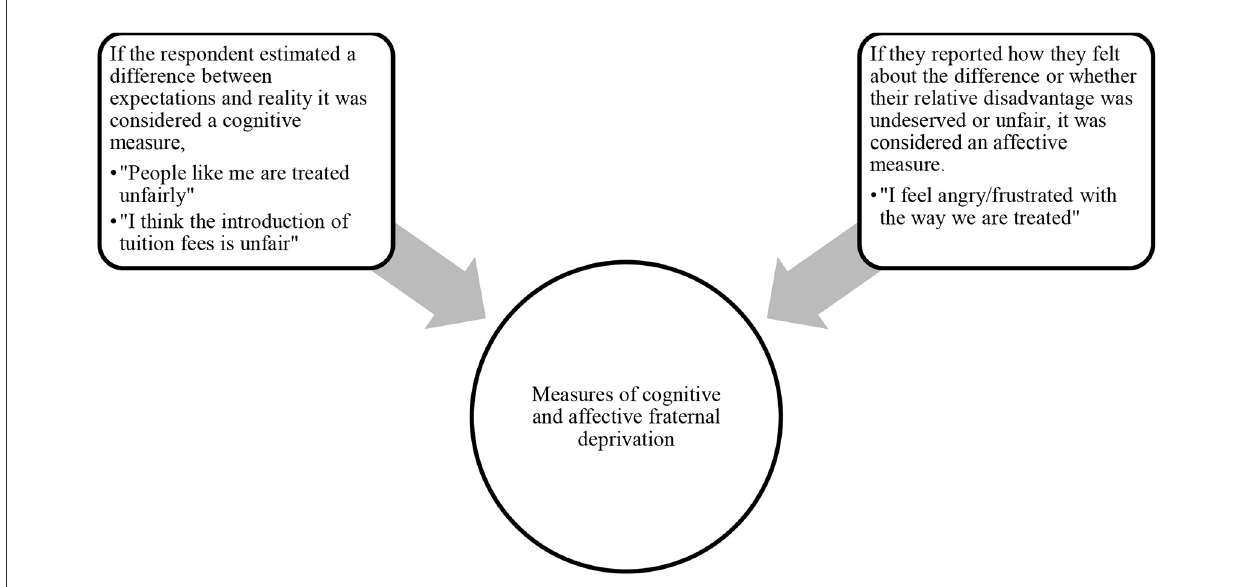
FIGURE2 Measures of relative deprivation (Agostini and van Zomeren, 2021).